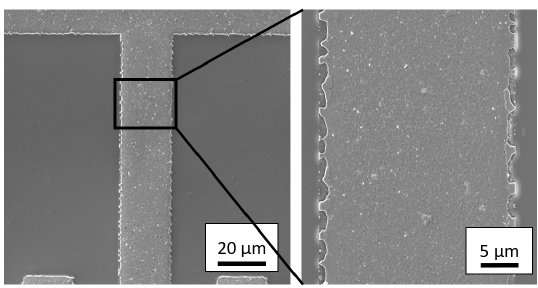
Figure 5. SEM image of a thin film layer (20nm Ti; 200nm Pt) after thermal ageing for 6h at 800 ◦